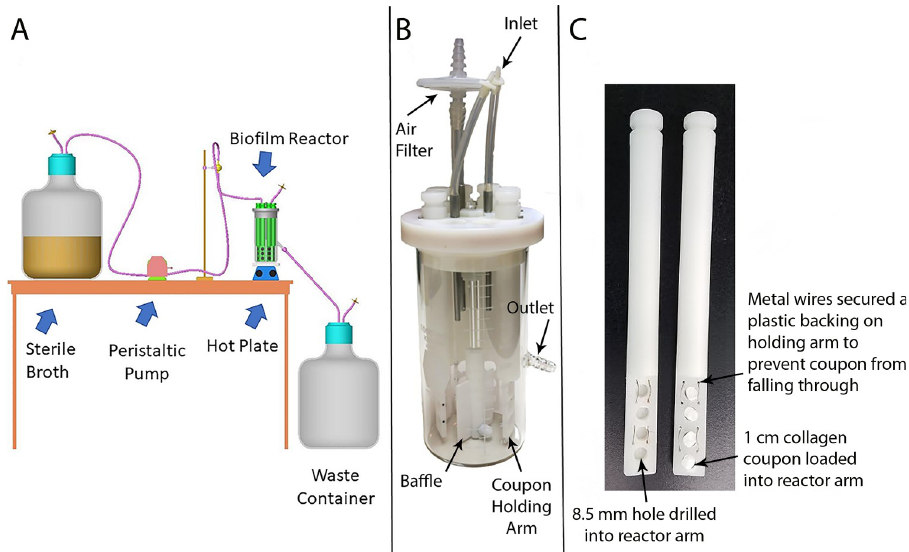
Fig 1. Design of the CDC biofilm reactor and modified holder. (A) Schematic of a general setup of a CDC biofilm reactor for biofilm growth. Source: Biosurface Technologies. (B) Components of a CDC biofilm reactor. (C) Customized rods into which collagen plugs were placed for biofilm growth. Labels detail